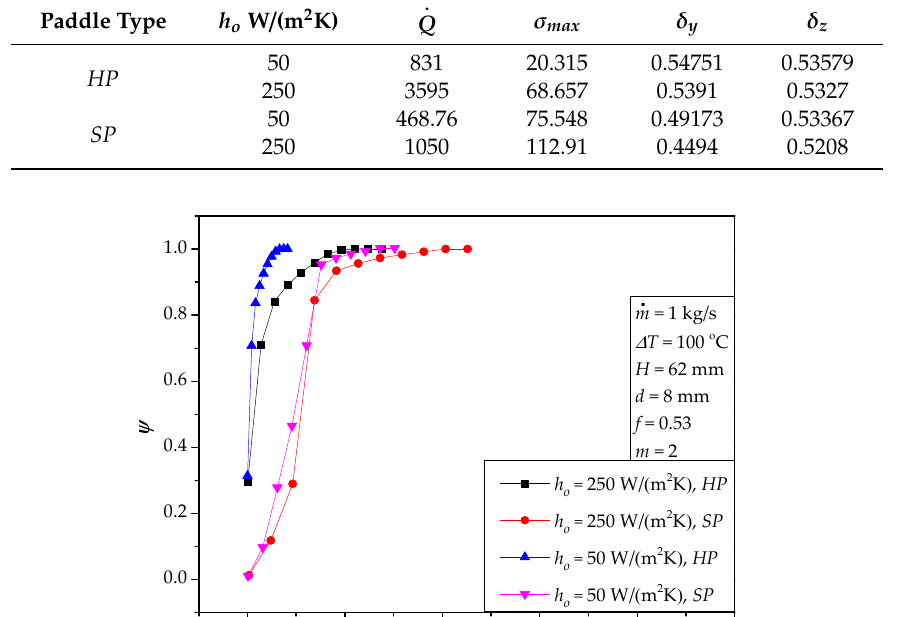
. m = 1 kg / s, H = 62 mm, d = 8 mm, φ = 0.53, m = 2.